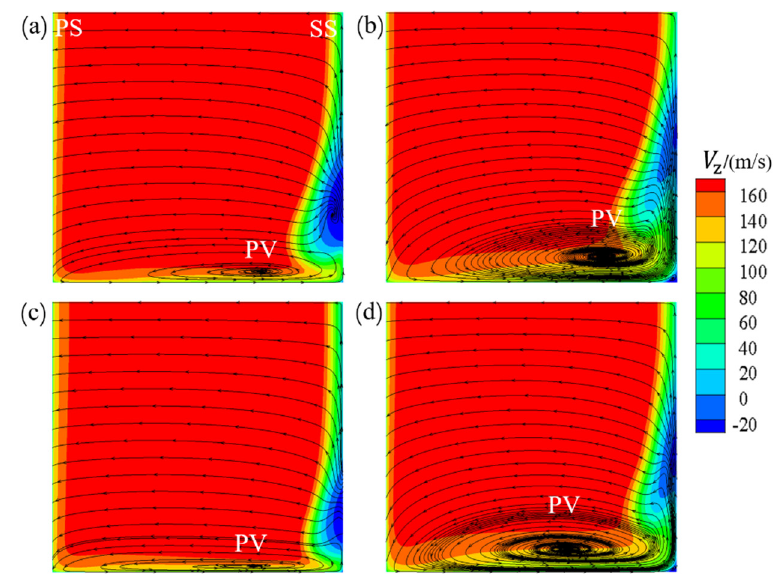
Figure 12. The axial velocity contours and streamlines of the cut planes (90% C a ) perpendicular to axial direction: ( a ) 0 mm collateral; ( b ) 5 mm collateral; ( c ) 0 mm skewed; ( d ) 5 mm skewed.